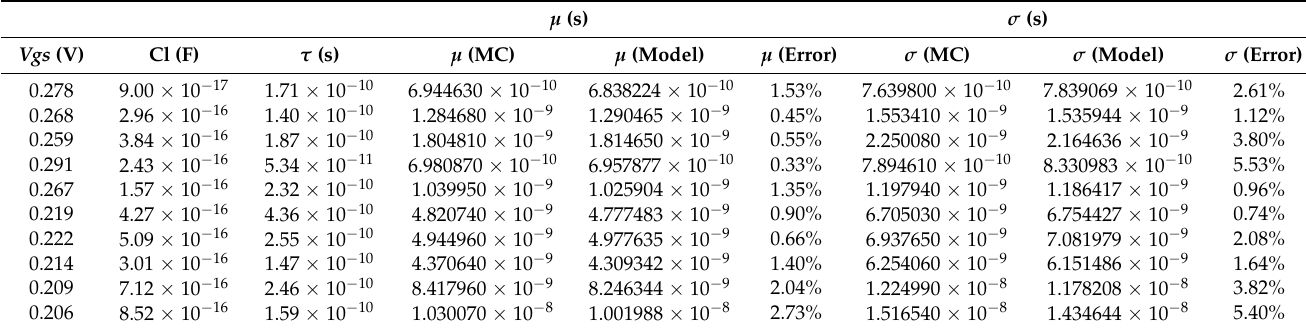
Table 16. Partial data under 28 nm technology (T = 25 ◦ C, Vbs = 0). µ (s) σ (s)